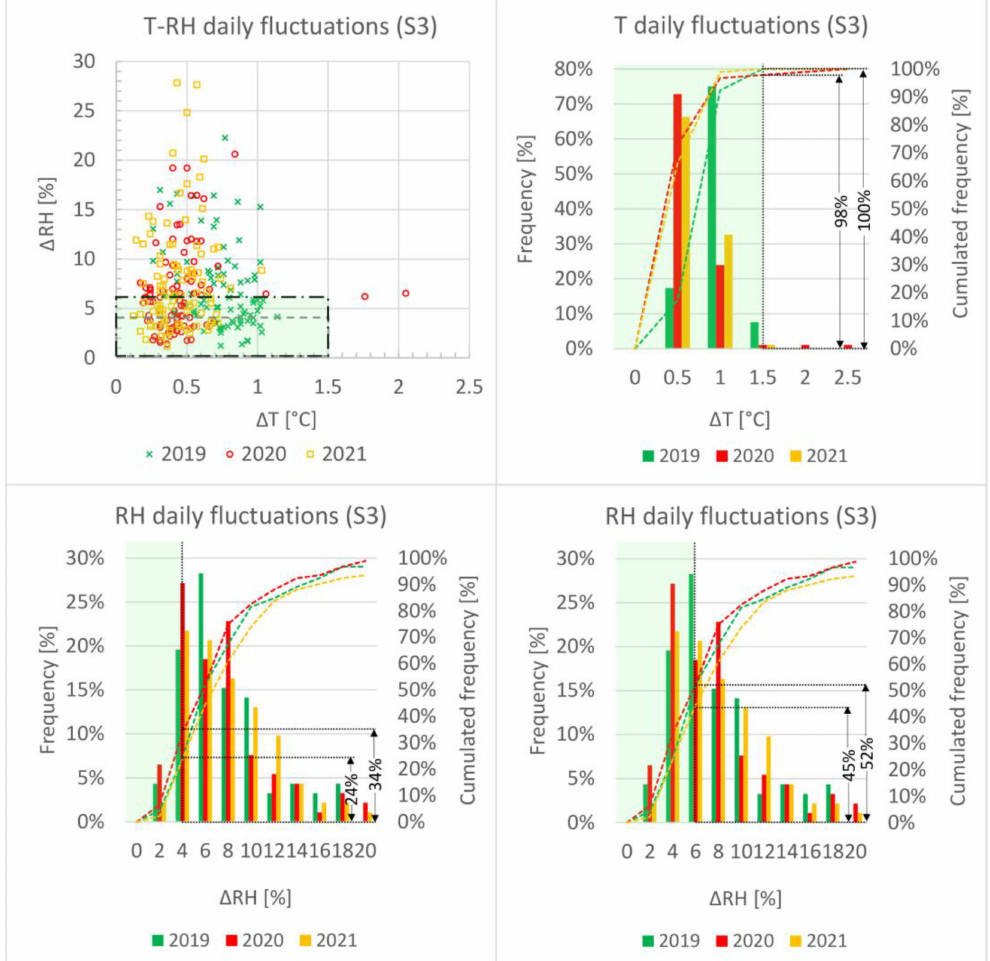
Figure 13. Scatterplot and frequency distribution comparison of indoor climate data (datalogger S3) from March to May 2019, 2020 and 2021 concerning the daily conservation range (the green area) proposed by